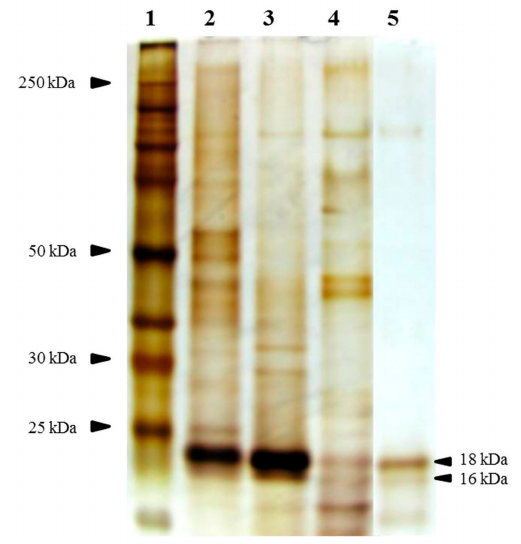
Figure A2. Protein profiles of Spirulina extracts determined by SDS-PAGE and silver nitrate staining. Lane 1, marker; Lane 2, Spirulina whole lysate; Lane 3, distilled water (DW) extract; Lane 4, ethanol (EtOH) extract; Lane 5, phycocyanin (Sigma, P-2172). Arrowheads indicate C-phycocyanin α , β